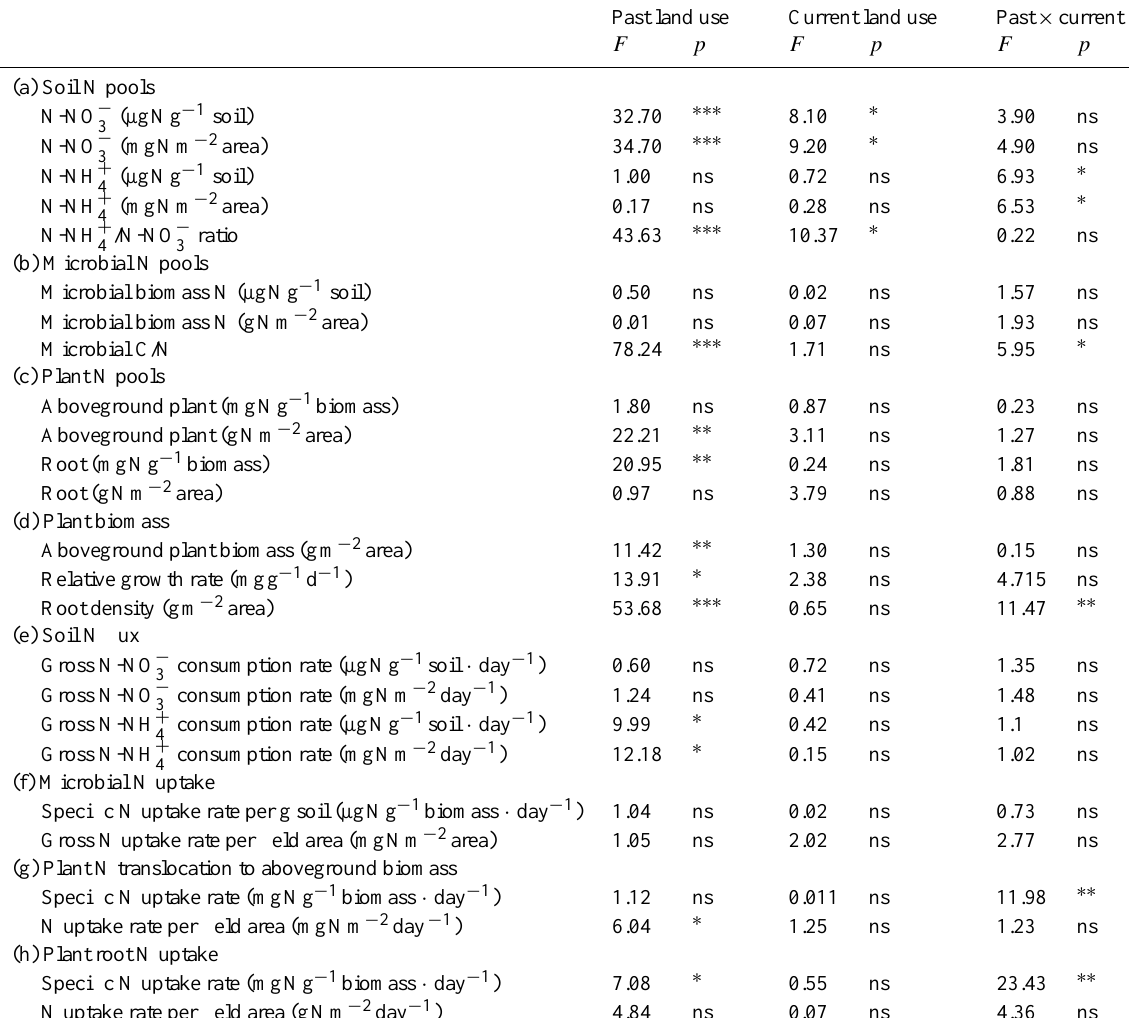
Table 1. Effect of past (terraced vs. unterraced) and current (mown vs. unmown) land uses on plant biomass, N pools and fluxes of soil, plant and microbial communities at the end of snowmelt in May 2010. Values are results of ANOVAs ( F ) and significance ( ∗∗∗ p < 0 . 001, ∗∗ p < 0 . 01, ∗ p < 0 . 05, ns: not